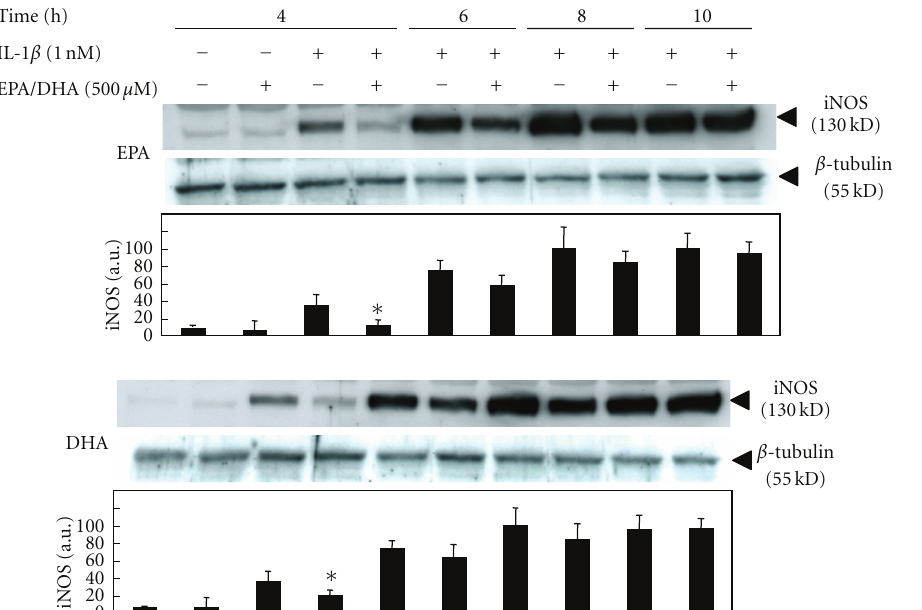
Figure 7: E ff ects of peroxidized EPA/DHA on the time course of iNOS protein expression. Cells were treated with IL-1 β (1nM) in the presence or absence of peroxidized EPA for 3 days and DHA for 1.5 days (each, 500 μ M) for the indicated times. Cell lysates (25 μ g of protein) were subjected to SDS-PAGE in a 7.5% gel, and immunoblotted with an anti-iNOS or anti- β -tubulin antibody. The bands corresponding to iNOS were quantitated by densitometry, and the levels of iNOS were normalized by thoseof β -tubulin (lower, mean ± SD, n = 3 experiments; ∗ P < . 05 versus IL-1 β alone).